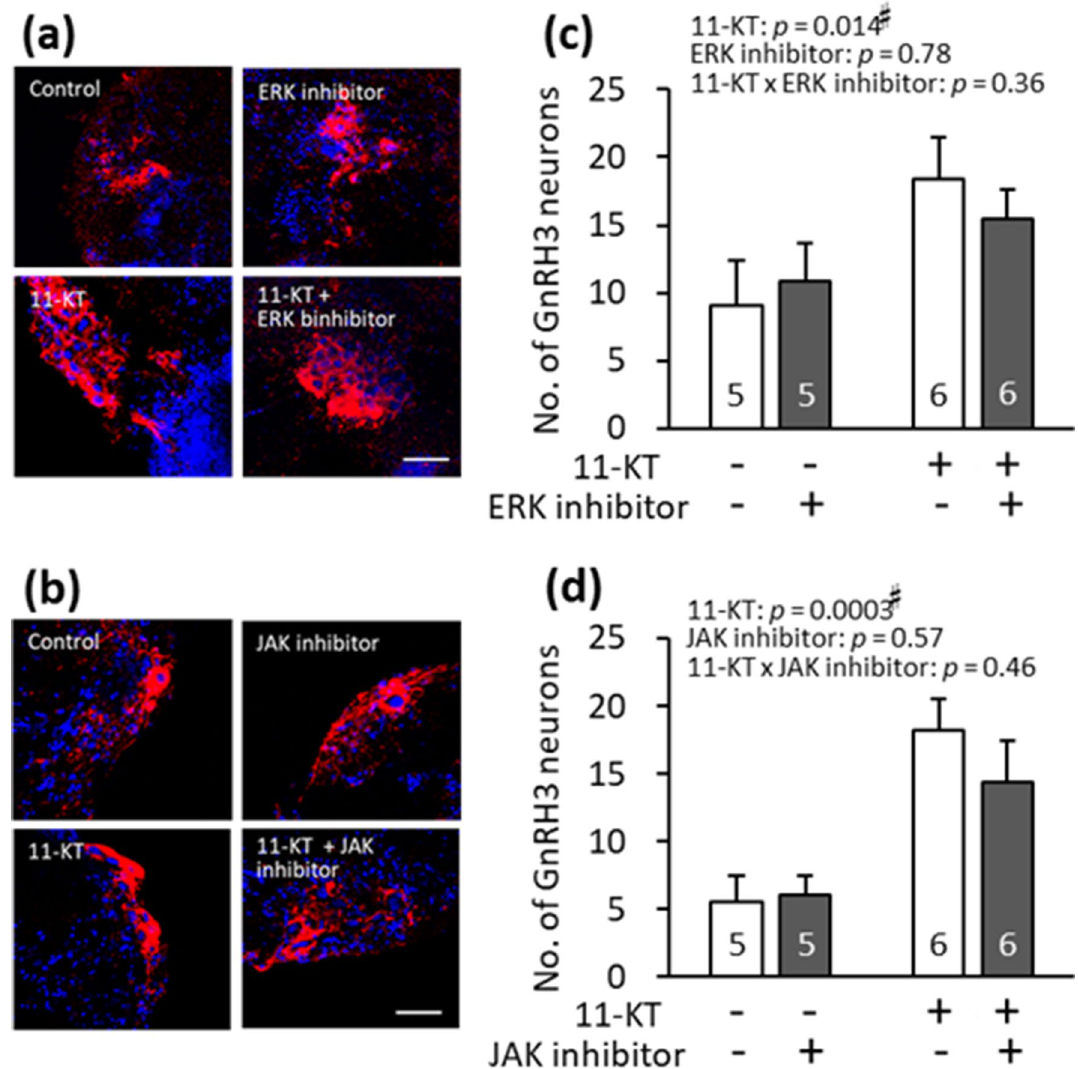
Figure 8. ( a , b ) Representative images of gonadotropin-releasing hormone 3 (GnRH3) neurons (red) in the following four groups of brain slices: control, inhibitor-treated, 11-ketotestosterone (11-KT)-treated (10 nM), and 11-KT- (10 nM) and inhibitor-treated groups. Cell nuclei (blue) were stained with Hoechst 33342. ( c , d ) The numbers of GnRH3 neurons in the four groups. Control and inhibitor-treated slices originated from the same animals, while 11-KT-treated slices and 11-KT- and inhibitor-treated slices originated from the same animals. Inhibitors used in ( a , c ) and ( b , d ) were as follows: ( a , c ) ERK inhibitor (20 μM U0126), ( b , d ) JAK inhibitor (100 nM, InSolution TM JAK inhibitor 1). Results from two-way analysis of variance (ANOVA) are shown in the top. Numerals in bars indicate the numbers of animals used for preparing slices. # , a significant difference at p < 0.05 (two-way ANOVA). Data are expressed as the mean ± standard error of the